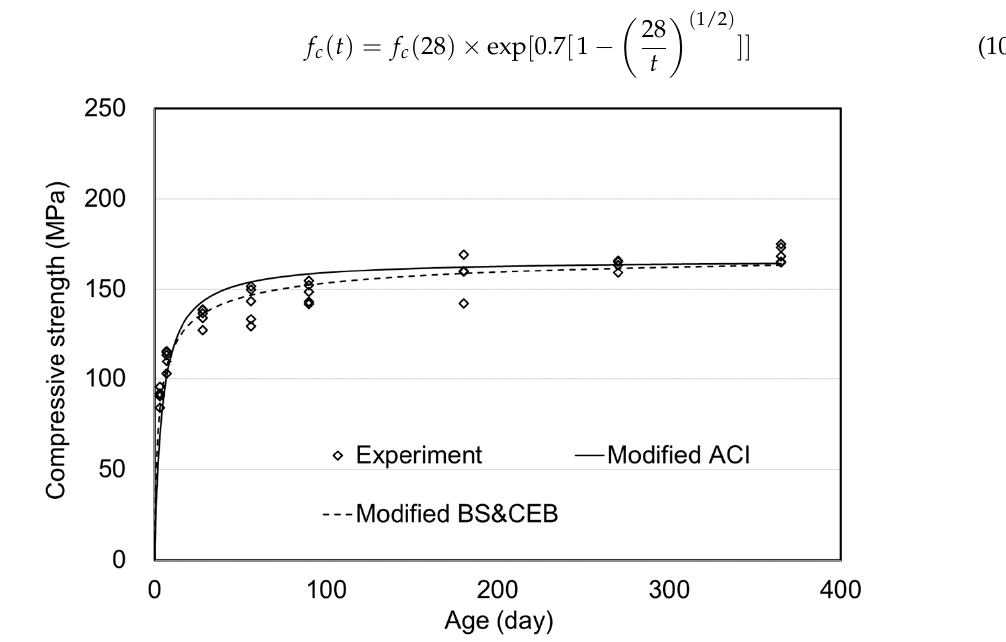
Figure 7. Prediction model of compressive strength for air curing. Table 4. Experiment results in moist curing compared with modified prediction models.